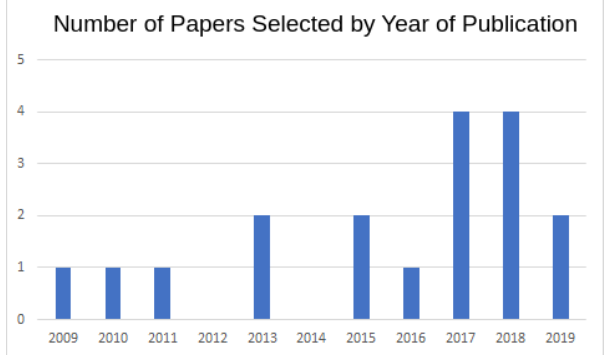
Figure 4. Number of Papers Selected by Year of Publication